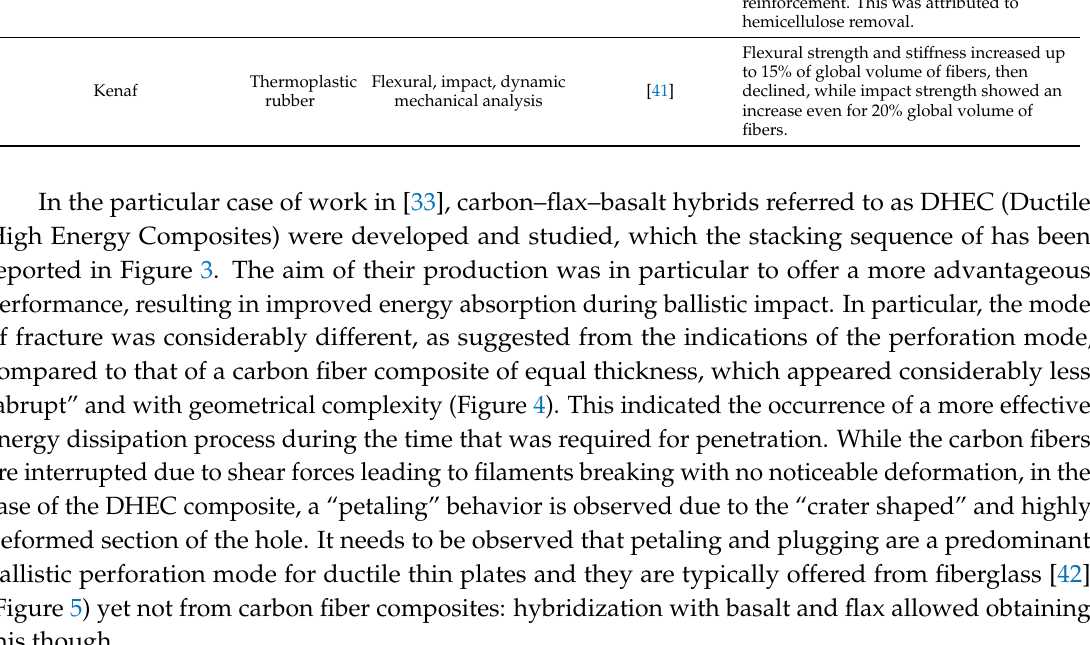
Figure 4. A comparison of the mode of penetration due to hybridization. (Original picture from the author of the chapter).